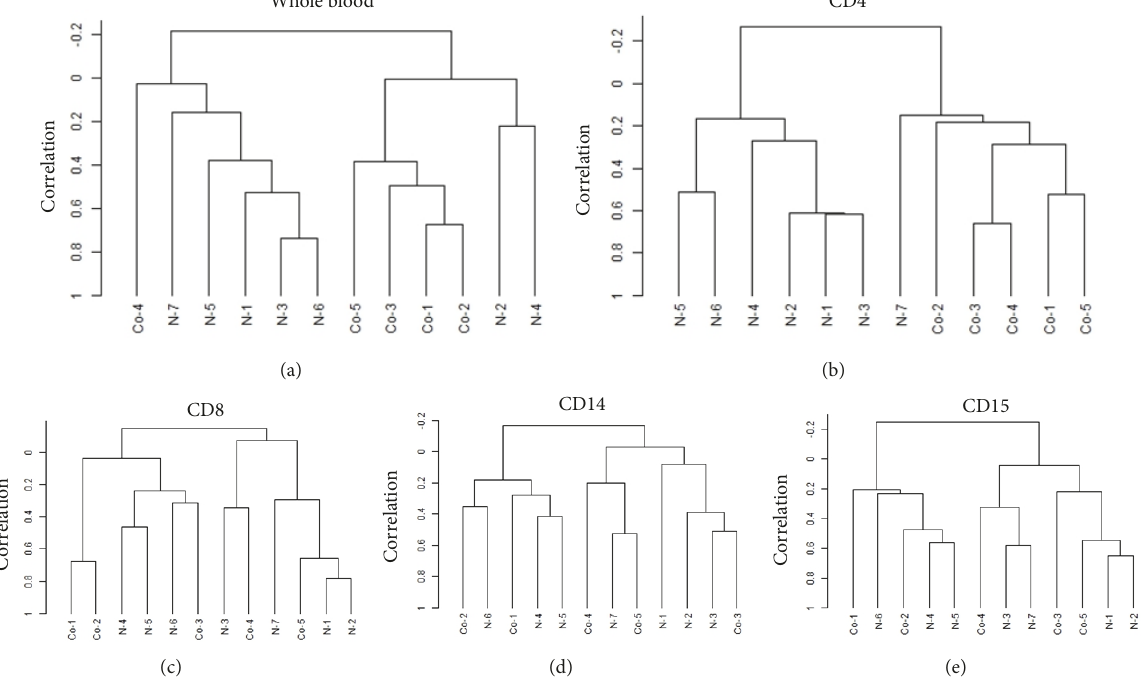
Figure 2: Unsupervised clustering analysis of the gene expression profiles of subfractionated peripheral blood cells. The dendrogram used for clustering using employed both correlations and average linkage for unsupervised analysis of the gene expression profile of peripheral blood. Significant up- or downregulated changes in gene expression ( ≥ 1.5-fold) in whole blood and CD4+ cells of CRC patients (compared to healthy volunteers) were observed for 3,243 and 2,459 genes at P -values < 0.05, respectively, but few such changes were observed in CD8+ cells, CD14+